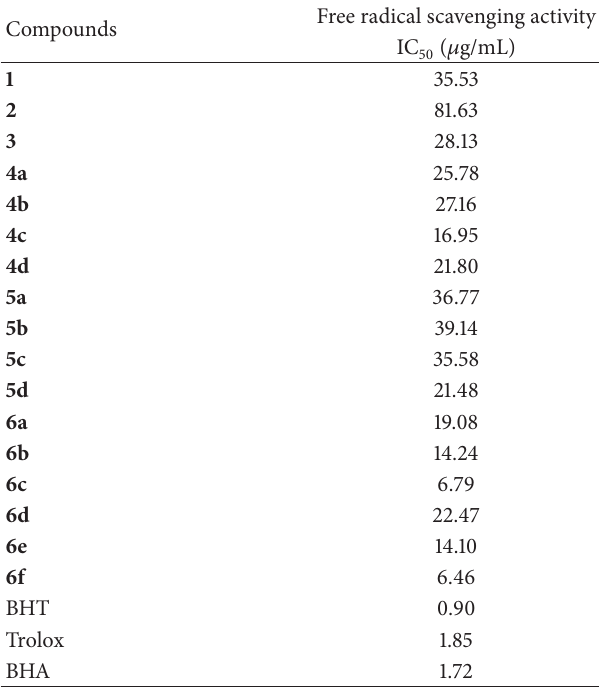
: 𝜇 g/mL) of new com- 50